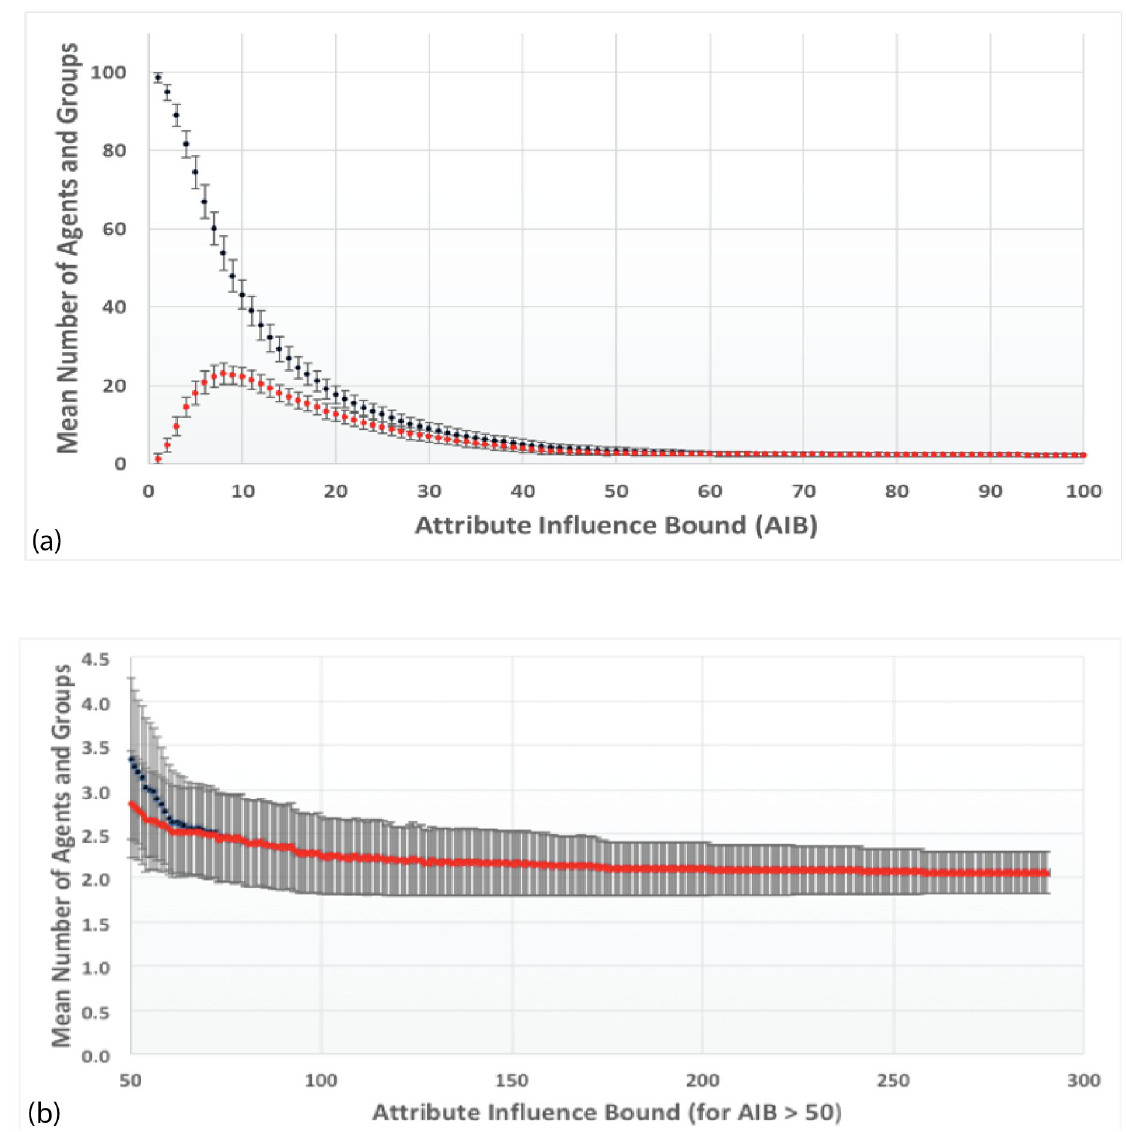
Fig 13. Mean number of agents (black) and groups (red) with standard deviations at the end of a simulation as a function of the Attribute Influence Bound (AIB). Standard Conditions, 100 runs/AIB value: a) AIB from 0 to 100; b) AIB from 50 to 280.